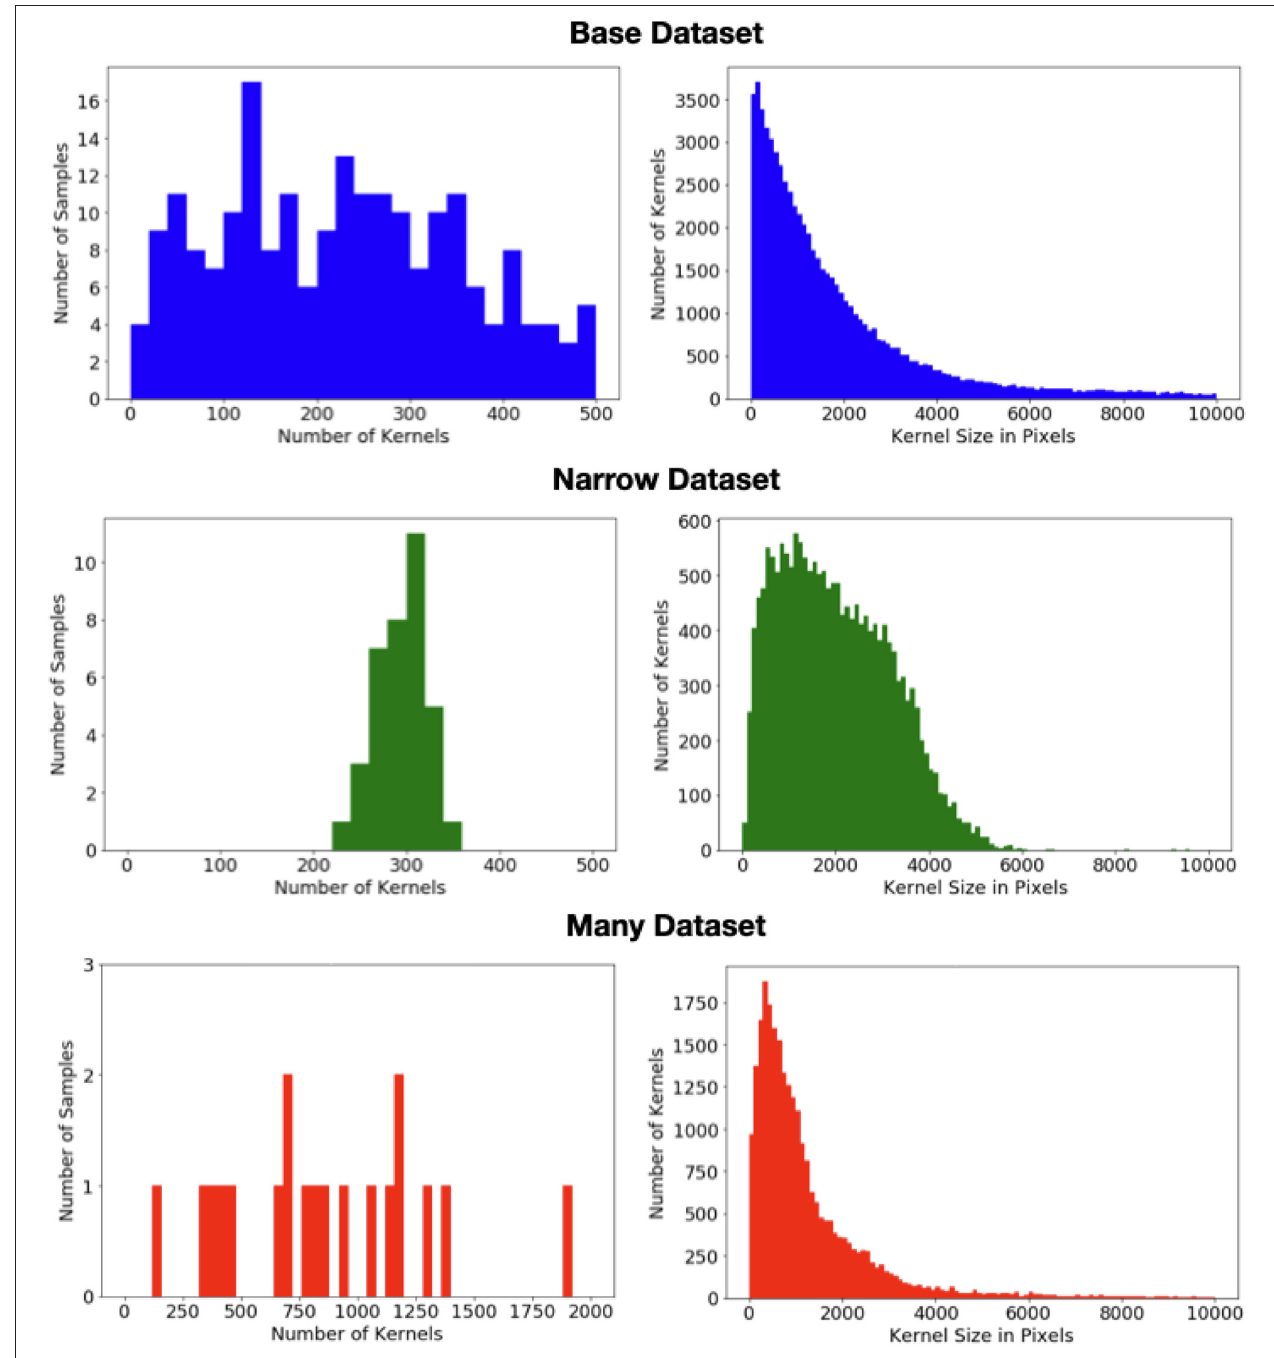
FIGURE 2 | (Left) Distribution of the number of kernels per image in each of the three datasets. (Right) Distribution of the kernel size (i.e., area) in pixels in each of the three